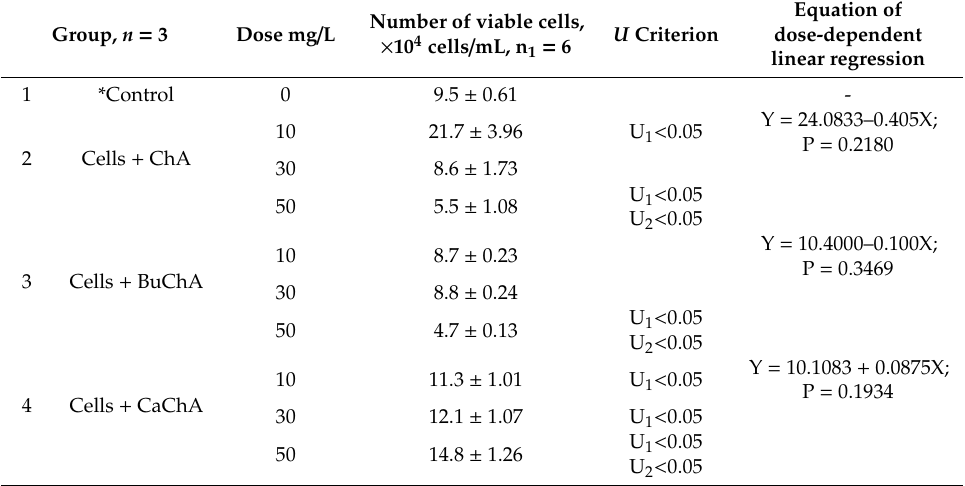
Table 1. The indices of human adipose-derived multipotent mesenchymal stromal cell (hAMMSC) viability after 21 days of culturing in the presence of tested compounds, X ± standard deviation (SD).